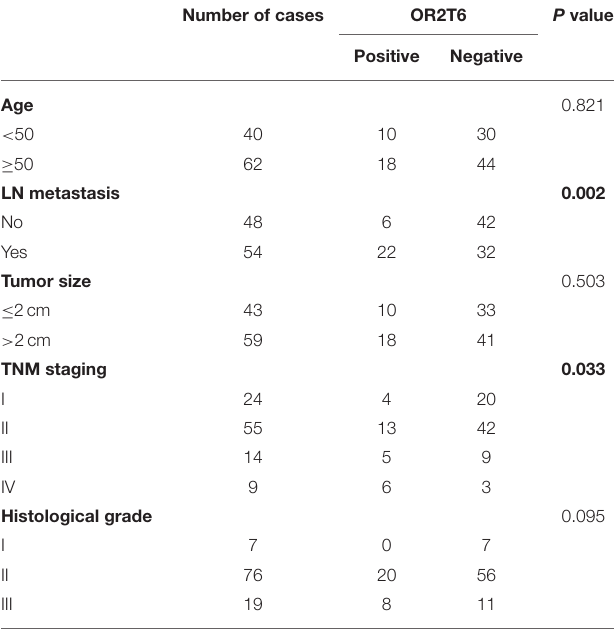
TABLE 2 | Association of clinicopathological parameters with OR2T6 protein expression. proliferation of breast cancer Number of cases OR2T6 P value Positive Negative 0.821